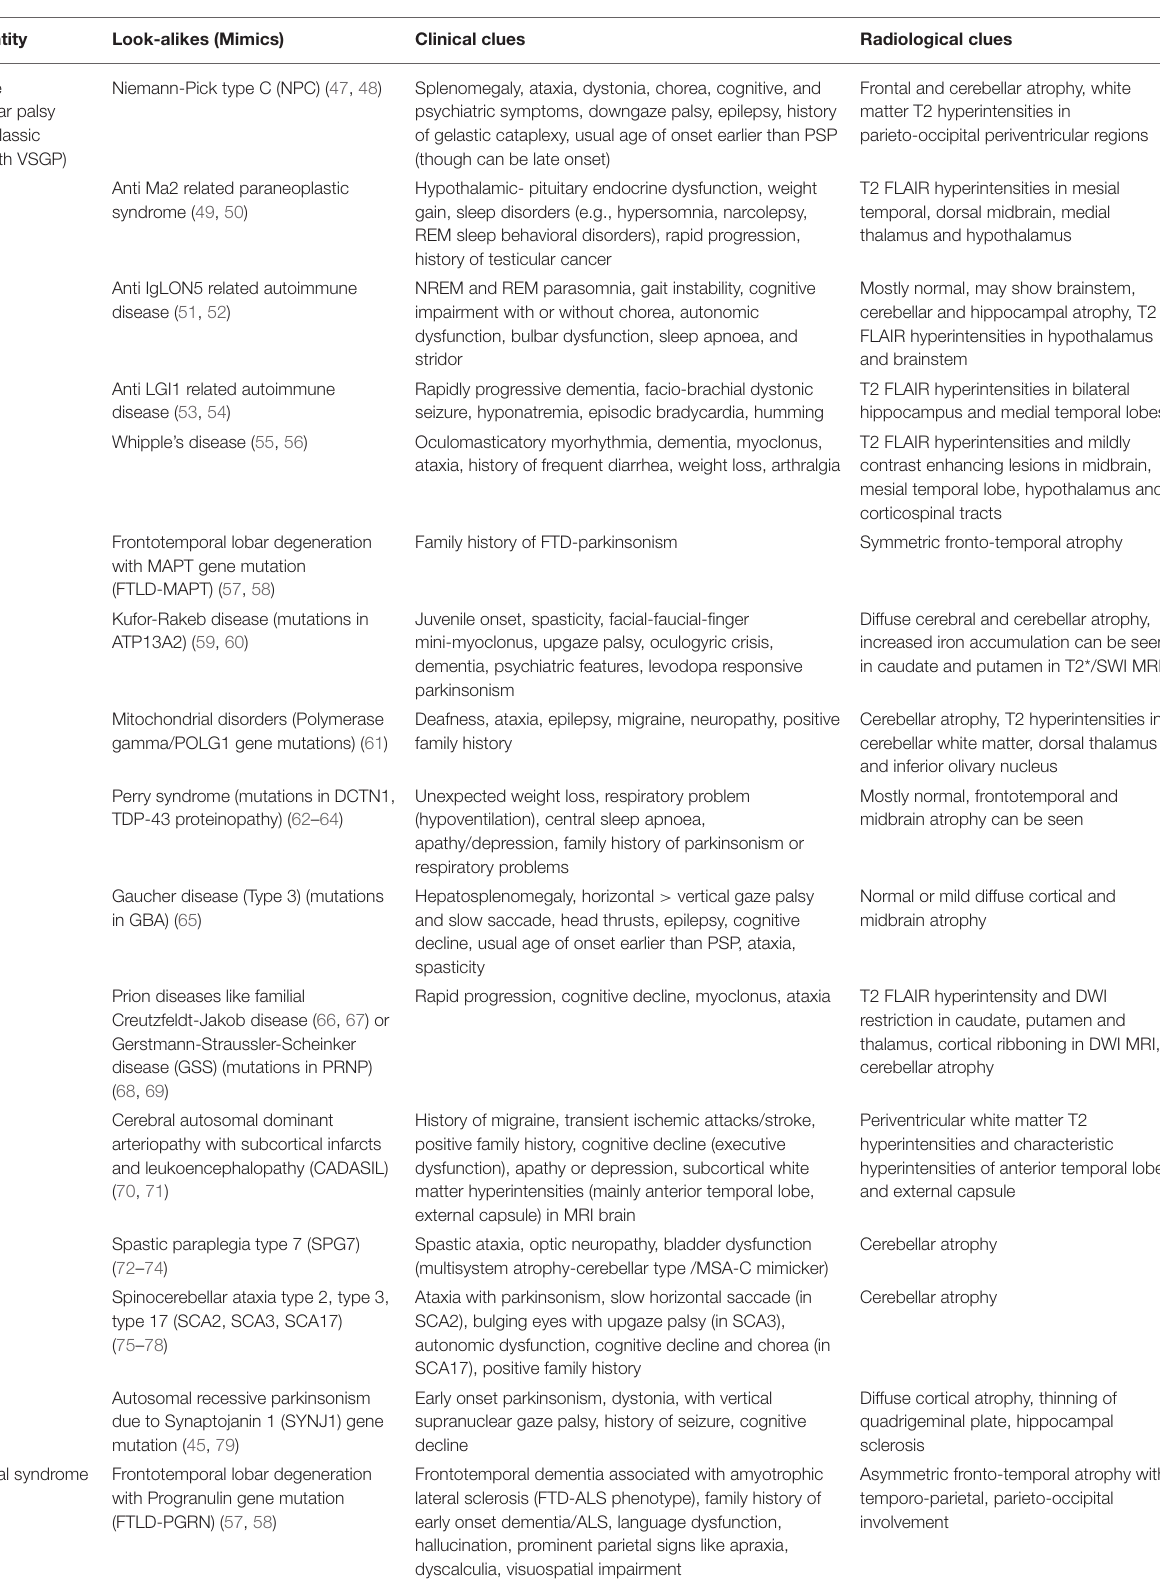
TABLE 2 | Mimics of PSP and